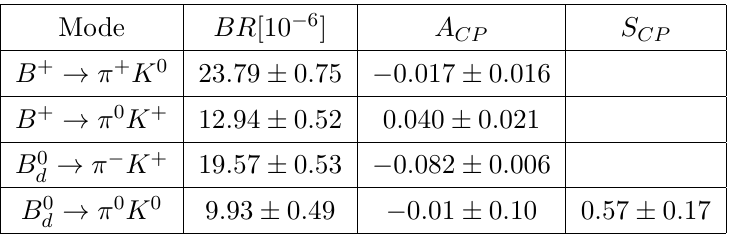
Table 1 . Branching ratios, direct CP asymmetries A CP , and mixing-induced CP asymmetry S CP (if applicable) for the four B ! (cid:25)K decay modes. The data are taken from ref.